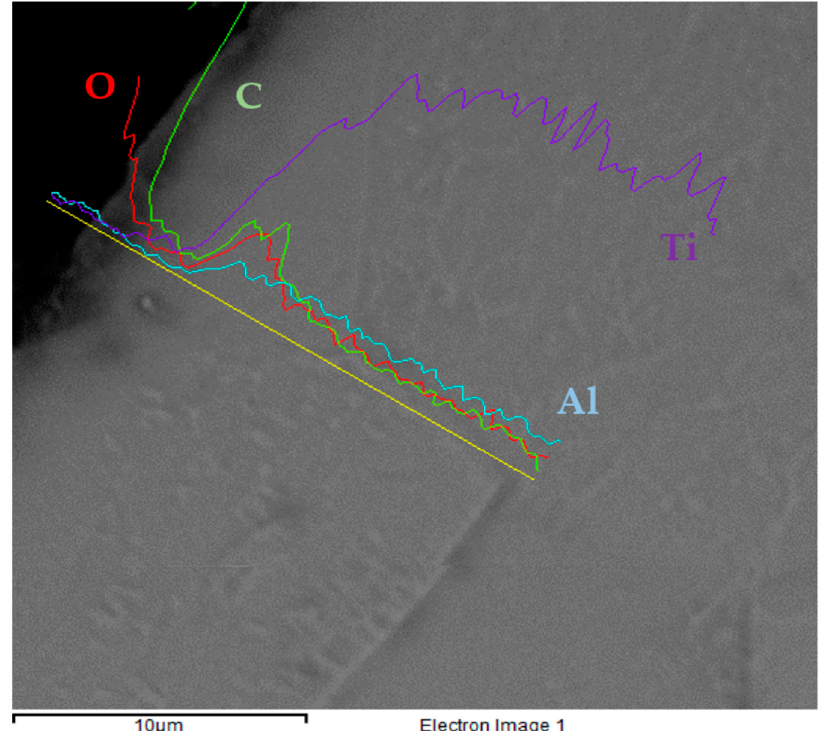
Figure 9. SEM micrograph of the polished and etched cross section of the plasma-treated sample and EDS line scan showing element distribution.